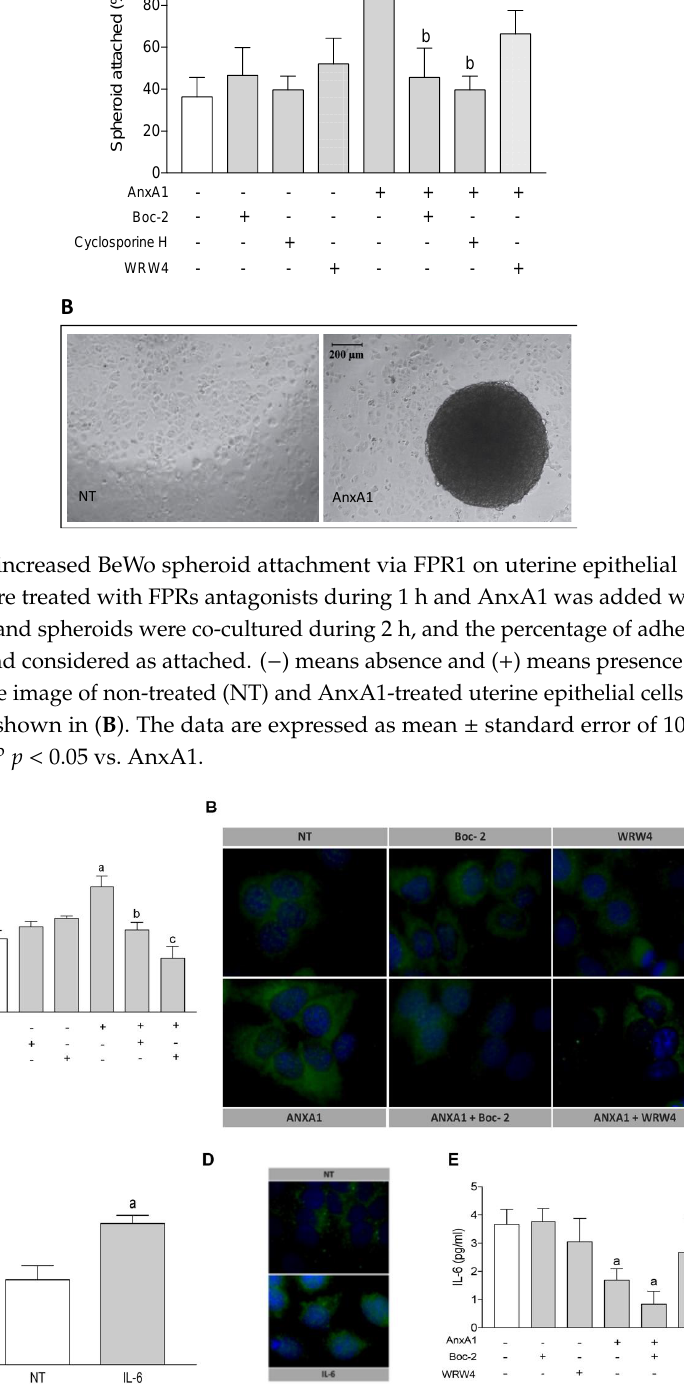
Figure 2. AnxA1 controlled Muc-1 expression on uterine epithelial cells via FPR1 / FPR2, independent of IL-6 secretion. Muc-1 expression on uterine epithelial cells was determined 24 h after incubations ( A , B ). Muc-1 expression was determined 24 h after IL-6 treatment ( C ). IL-6 secretion was determined in the supernatant of uterine epithelial cells 24 h after treatments ( D ). ( − ) means absence and ( + ) means presence of treatments. The data are expressed as mean ± standard error of mean of three to five independent experiments. a p < 0.05 vs. NT; b,c p < 0.05 vs.